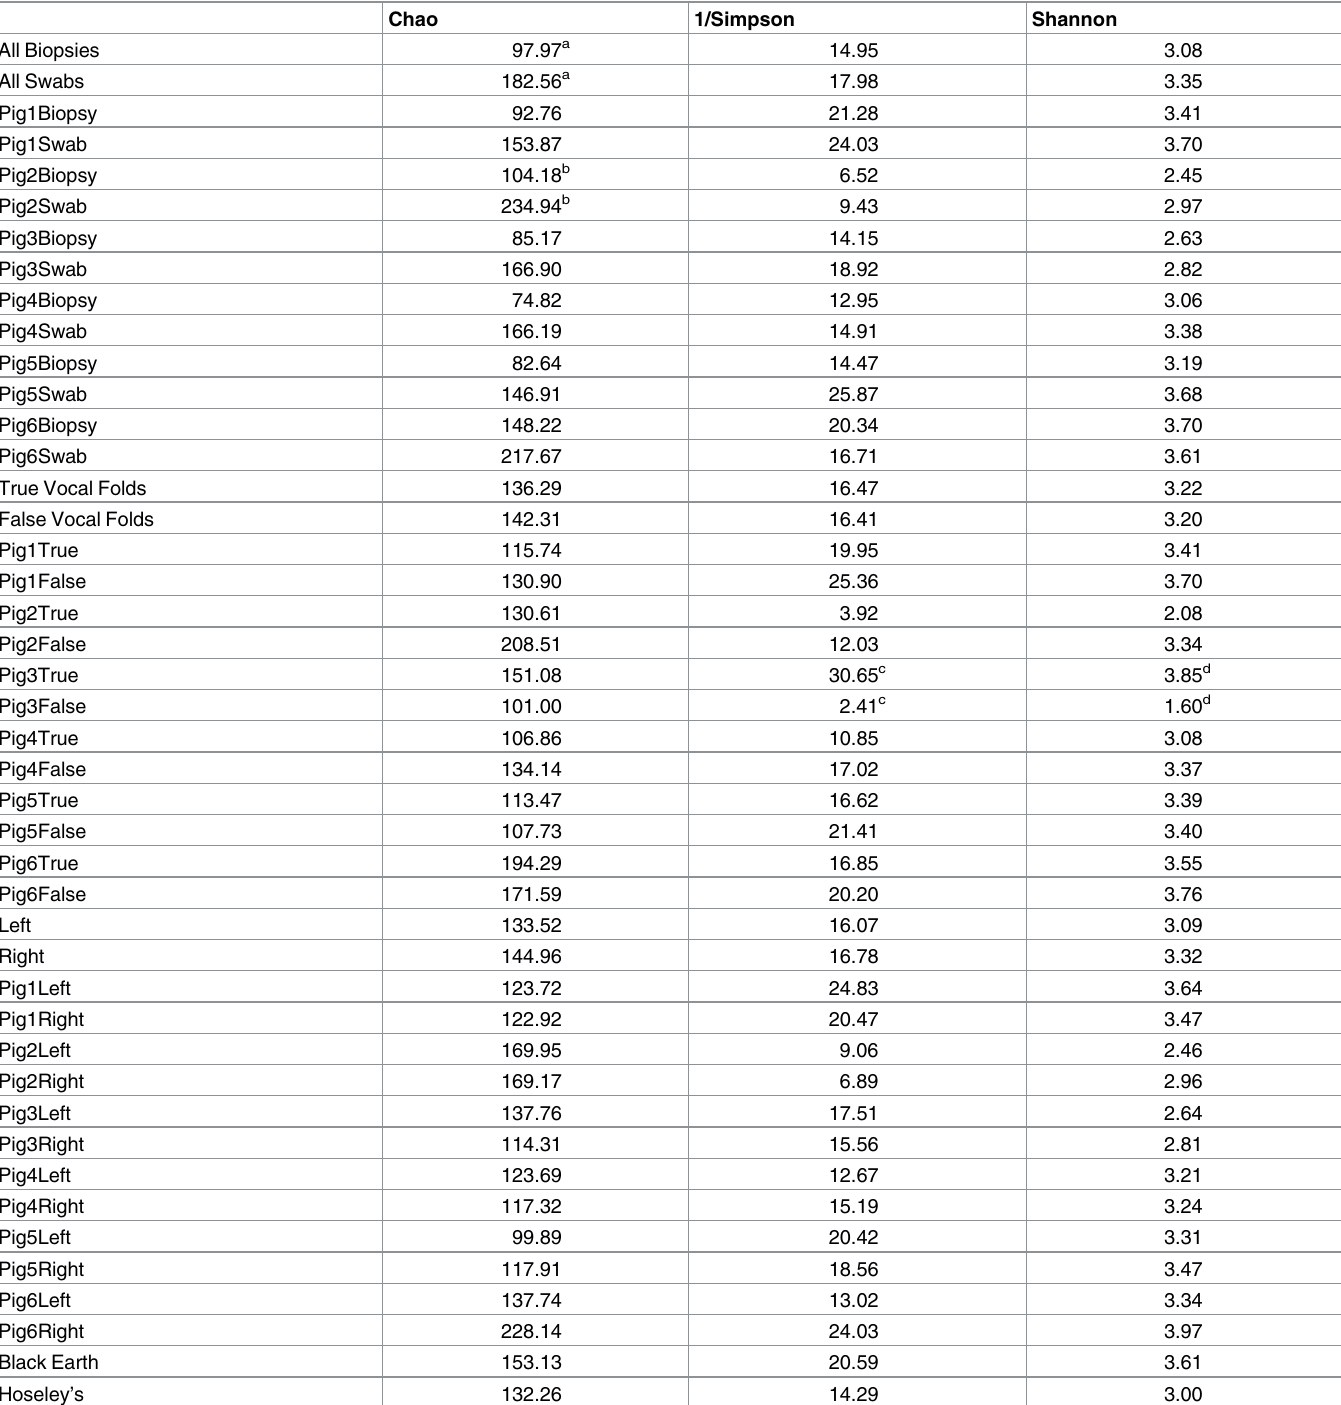
Table 1. Mean of sequence